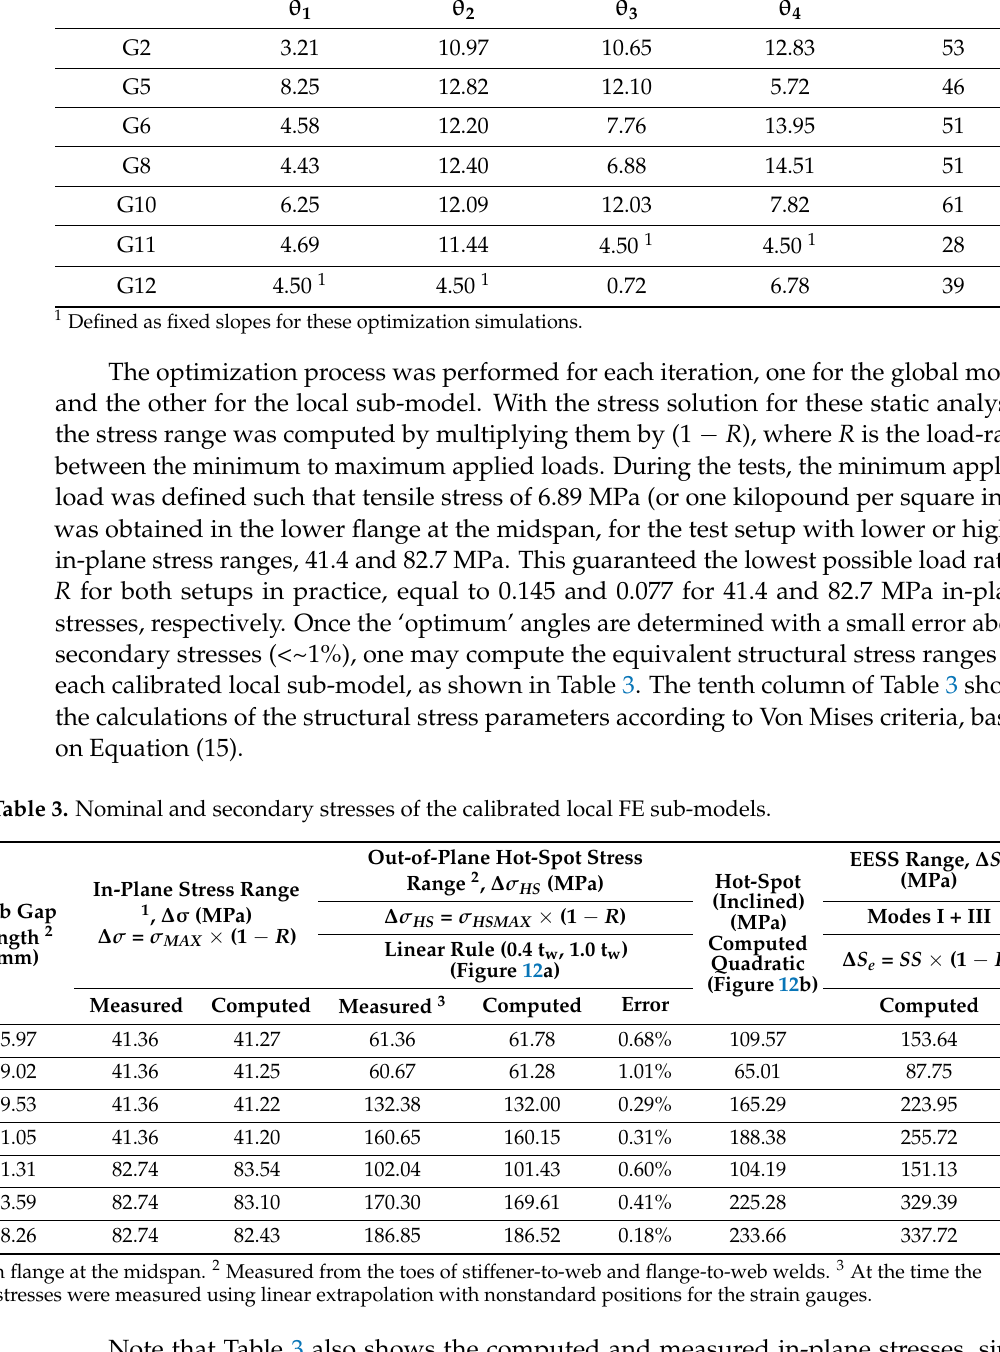
No. of Iterations Girder